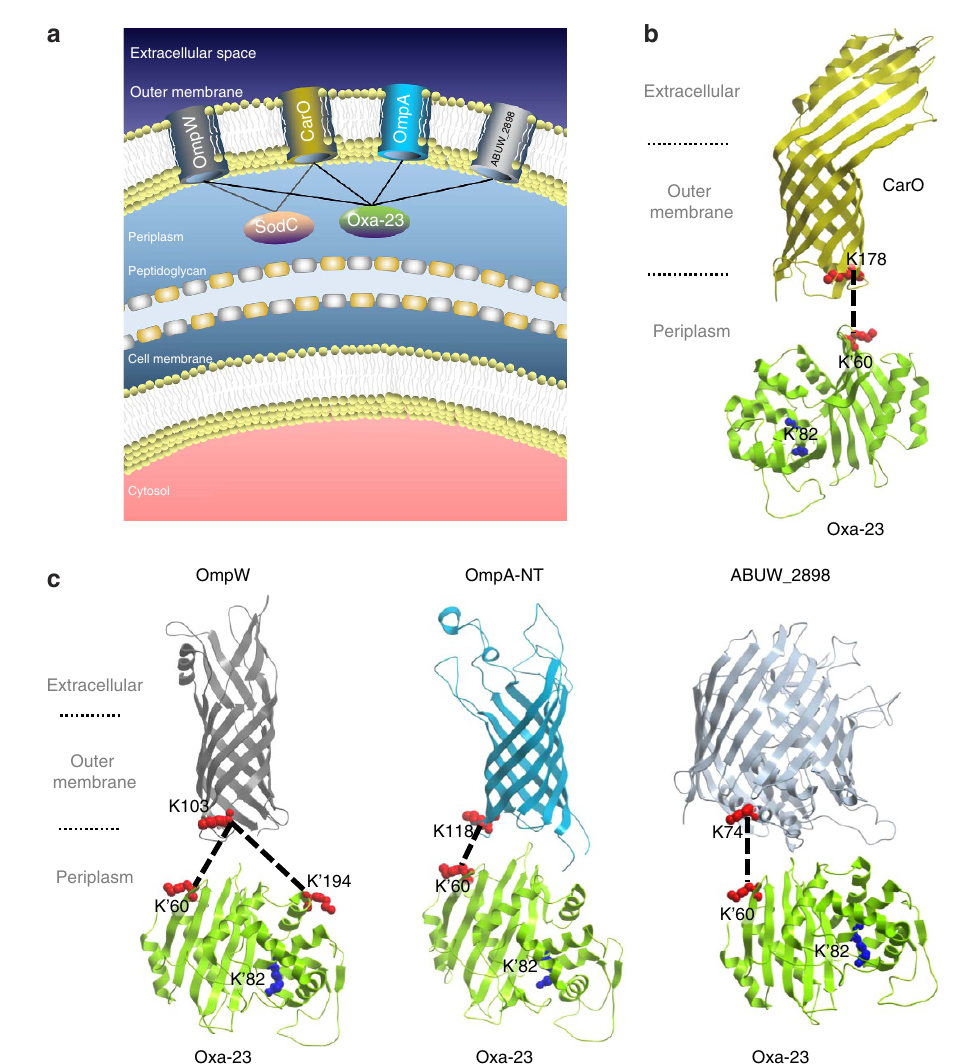
Figure 3 | Protein interactions of Oxa-23 with outer membrane porins. ( a ) Summary model showing interactions of periplasmic enzymes Oxa-23 and superoxide dismutase SodC with the OM porins that may help localize Oxa-23 and SodC near the inner surface of the OM. ( b ) Structural features of Oxa- 23 interactions with the eight-stranded b -barrel of CarO porin. PDB structures Oxa-23 (4FJ6) 43 and CarO (4FUV) 60 were used. ( c ) Structural features of Oxa-23 interactions with OmpW, OmpA-NTand ABUW_2898. Structural models of the 8 stranded b -barrel of OmpW, OmpA-NTand the 18-stranded b - barrel of ABUW_2898 were generated with Phyre2 (ref. 50) using E. coli templates OmpW (2F1T) 74 , OmpA-NT (1G90) 75 and Wzi (2YNK) 51 . It is noteworthy that OmpA has also been proposed to fold into a one-domain, open-channel conformation 15,76 . However, structural models of the open- channel forms are not available. The subcellular compartments, the identified cross-link sites and Oxa-23 catalytic site K82 are